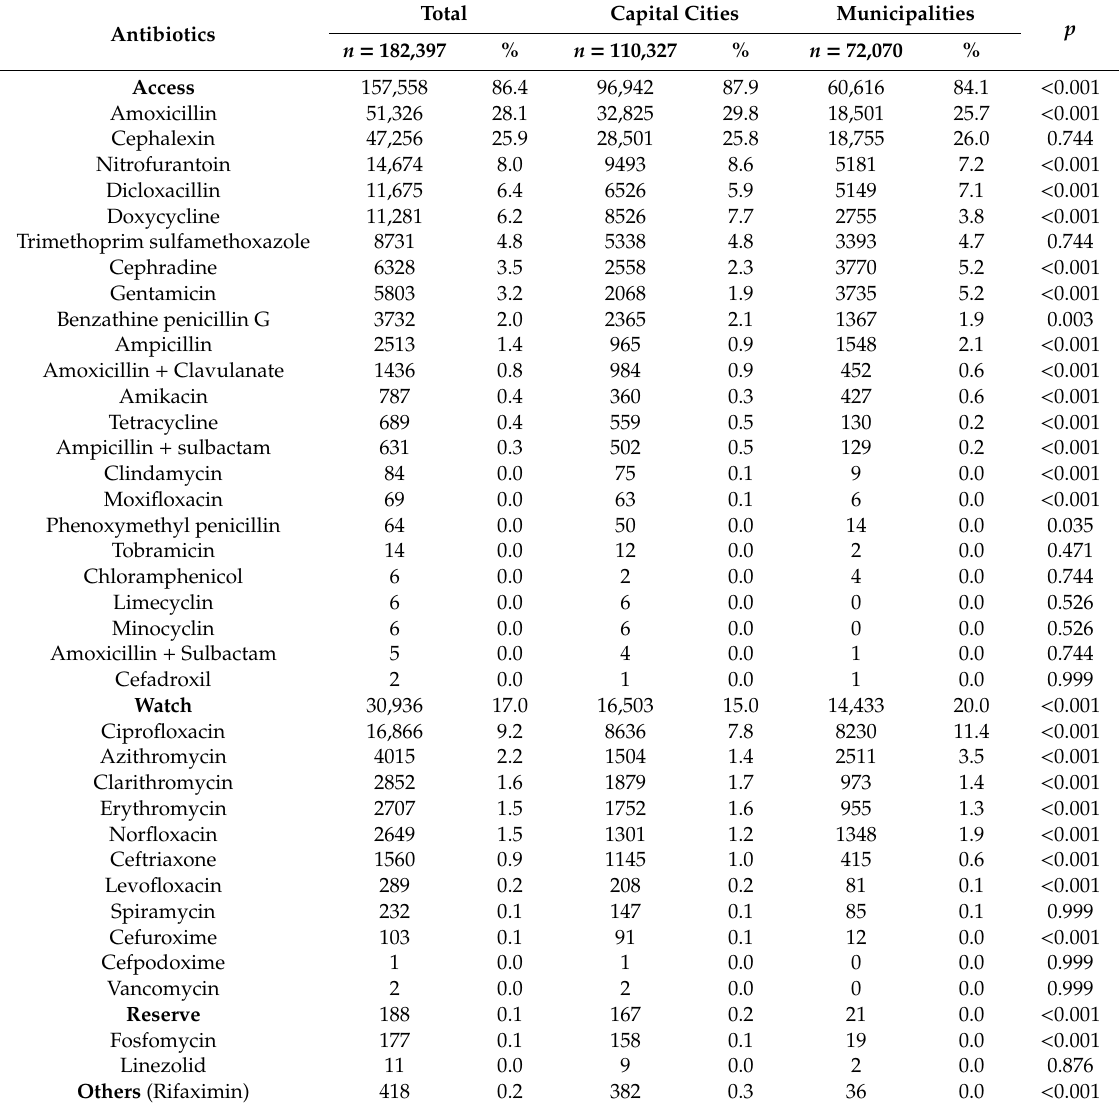
Table 2. Comparison of the antibiotics prescribed in the Capital cities and the small Municipalities, according to the AWaRe classification ( p values calculated by Chi-square / Fisher’s exact test, and adjusted using the Benjamini–Hochberg